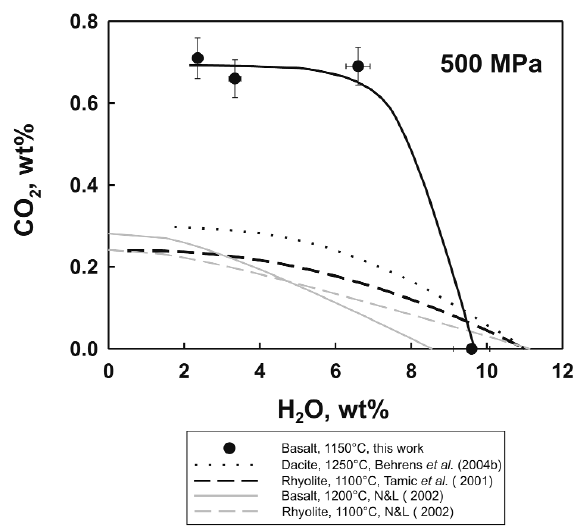
Fig. 5. The solubility of H 2 O and CO 2 in melts of different compositions at 500 MPa. The experimental strat- egy used for the basaltic system (OB93-190) and description of the lines are given in Appendix A and fig. 4. Note the significant increase in CO 2 solubility in basalt (by a factor of 2 to 3) when compared with rhyolitic and dacitic compositions.